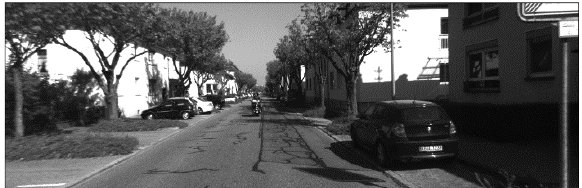
Figure 6. KITTI image example